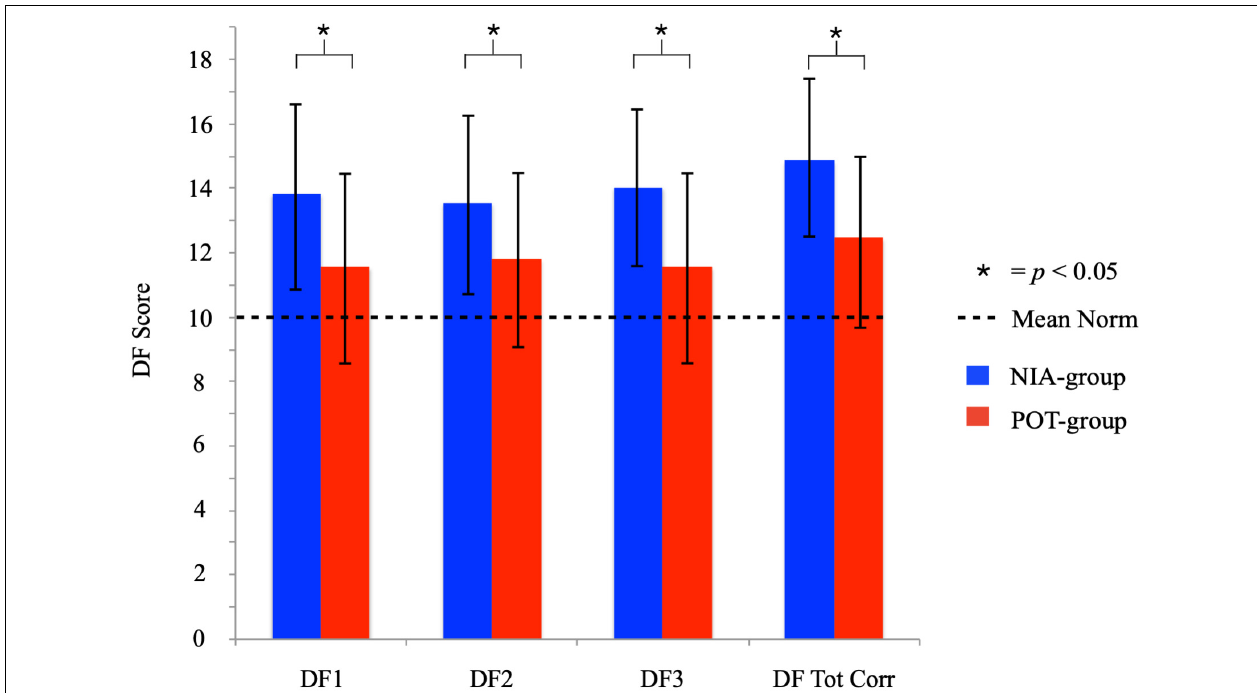
FIGURE 1 | Mean and standard deviation (SD) of all the DF subtests (DF1, DF2, DF3) and the DF total score (DF Total C) in NIA-group and the